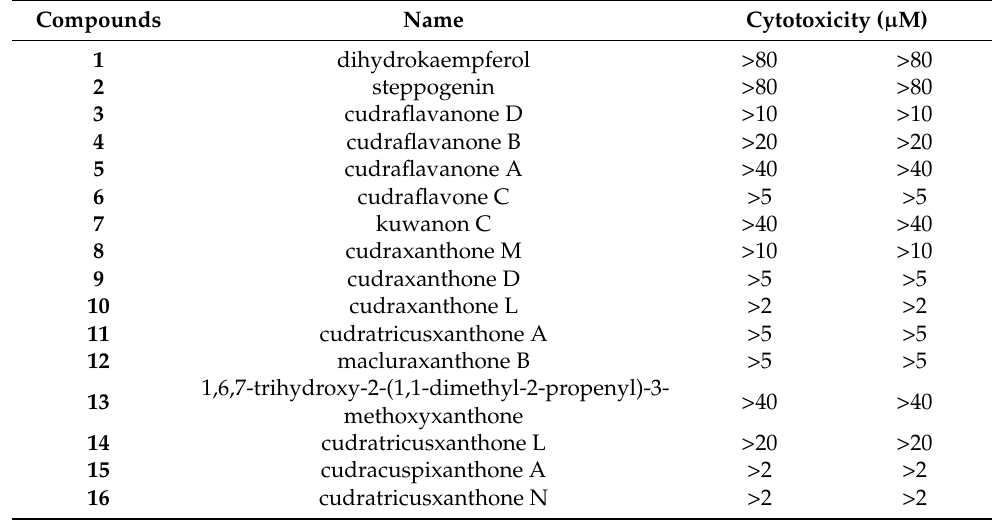
Table 2. Effects of the 16 compounds from C. tricuspidata on the viability of HaCaT cells.